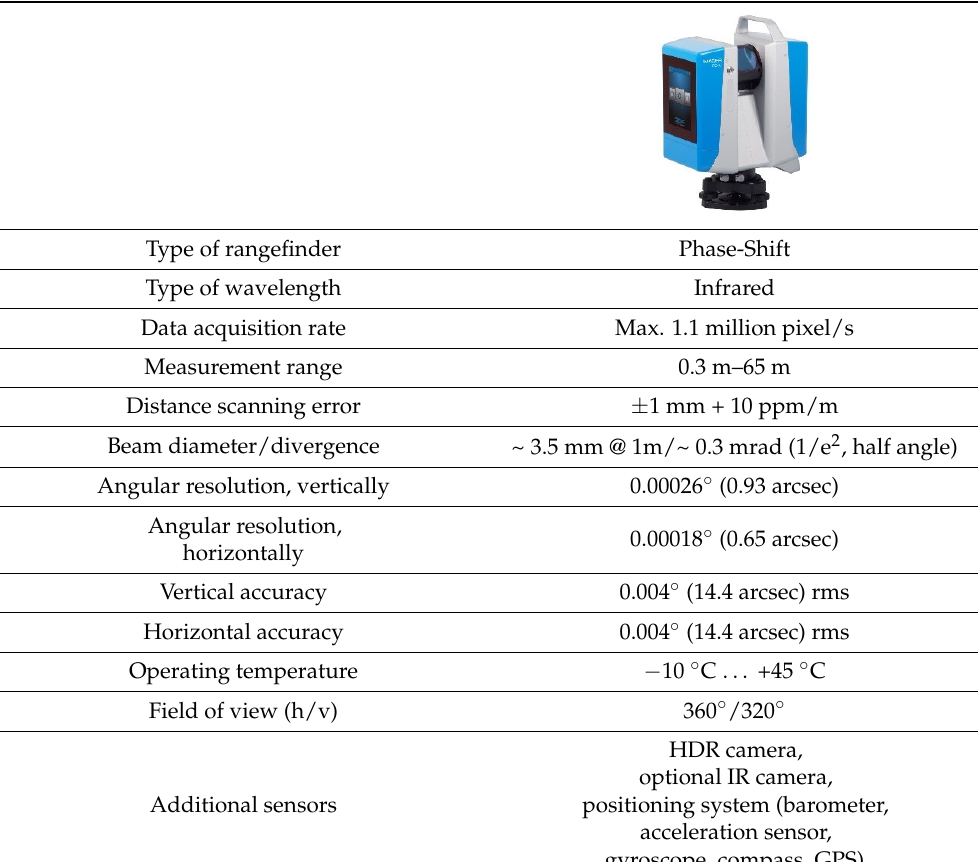
Table A1. Basic characteristics of Z+F Imager 5016 terrestrial laser scanners.